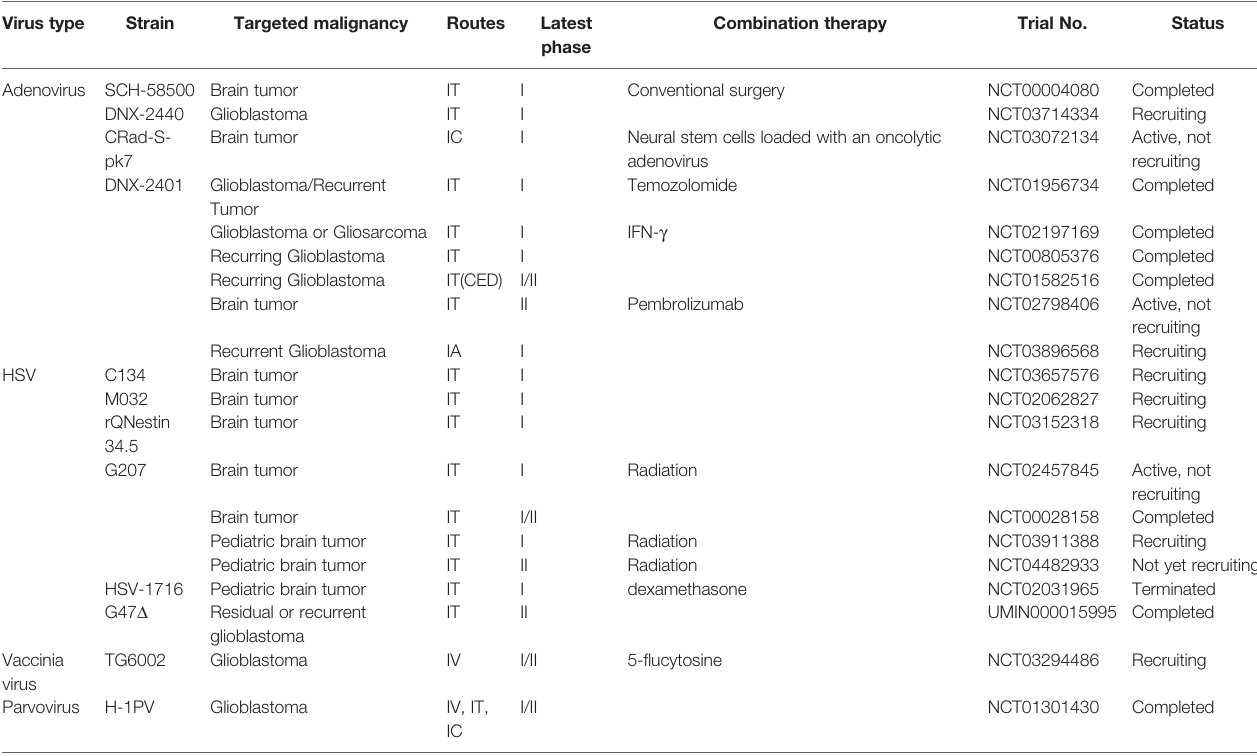
TABLE 2 | Current clinical trials utilizing DNA viruses against